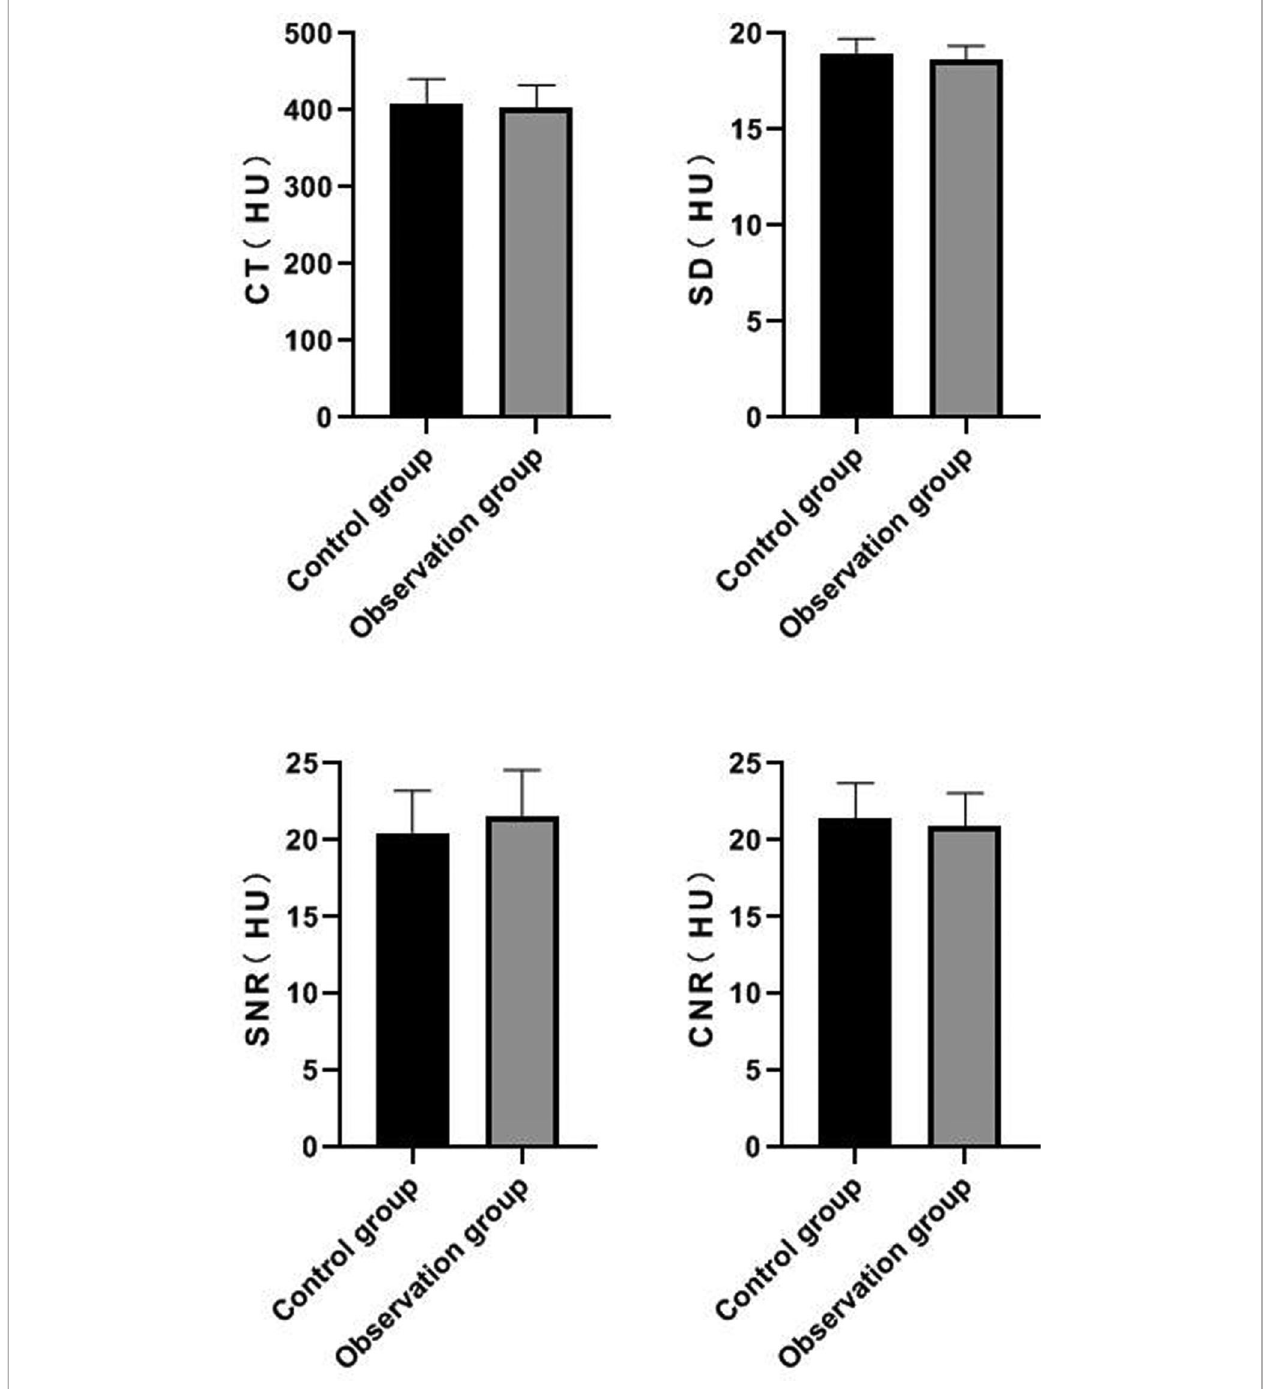
FIGURE 3 | Comparison of measured values of popliteal artery segment between the two